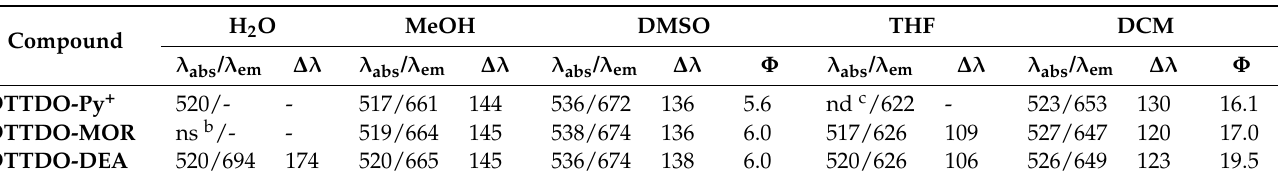
Table 3. Maximum absorption ( λ abs ), emission ( λ em ) , Stokes shift ( ∆ λ ), and quantum yield ( Φ ) of DTTDO derivatives in different solvents a